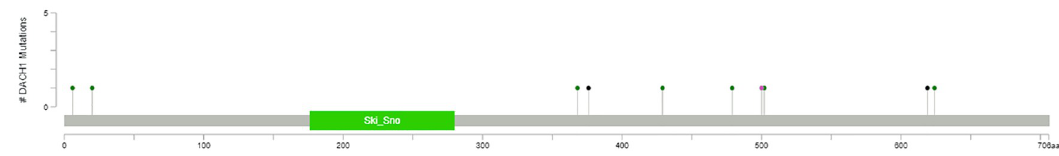
Fig 2. Lollipop plot of DACH1 gene mutations in the 65 patients in the Markey Cancer Center. Missense mutations are green. Truncating mutations are black and include nonsense, nonstop, frameshift deletions, frameshift insertions, and splice site mutations. All other types of mutations are included as pink (excluding fusion and inframe deletion or insertions).